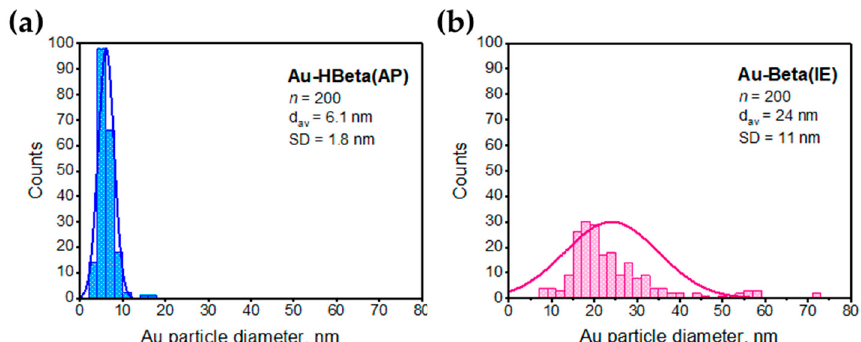
Figure 4. Gold particle size distributions estimated for ( a ) Au-HBeta(AP) and ( b ) Au-Beta(IE) by counting n = 200 particle diameters in each sample. The average Au particle diameter (d av ) and standard deviation (SD) were determined.